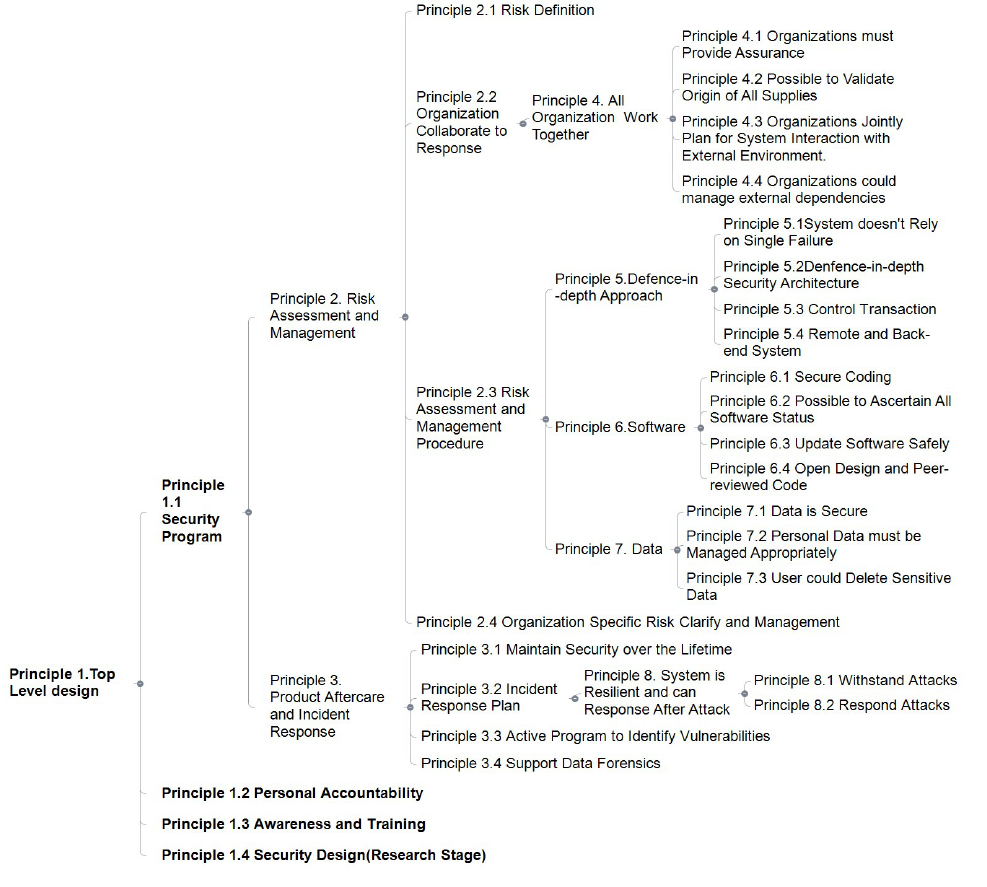
Figure 1. Structure of UK Connected and Autonomous Vehicle (CAV) cyber security principles (structured from